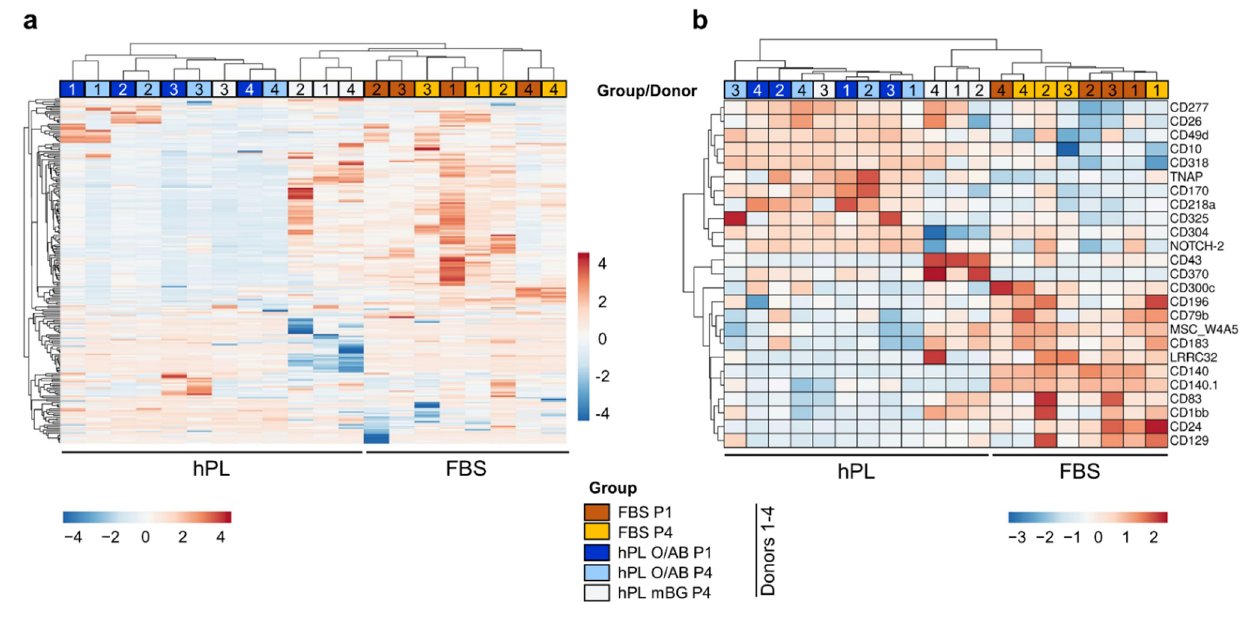
Figure 4. Cell surface marker profiling of BMSCs. ( a ) Hierarchical clustering heatmap showing relative cell surface marker expression of all samples and culture conditions as indicated, based on isotype control staining of the corresponding target antibody. Individual marker expressions were row Z-score normalized. Lower expression in blue and higher expression in red as indicated by color. Gating strategy depicted in Figure A1. ( b ) Hierarchical clustering heatmap of cell surface markers that exhibited significant median differences of at least 10% between BMSCs in hPL O/AB and FBS.